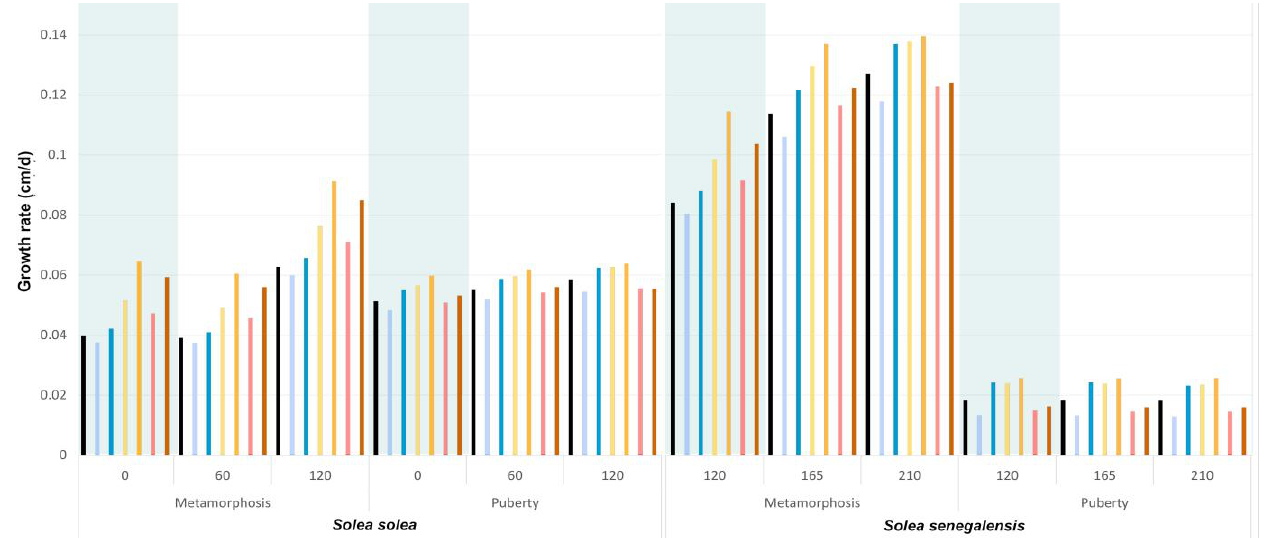
35 of 39 Figure A5. Predicted age and size at different stages, stage duration and growth rates for Solea spp.